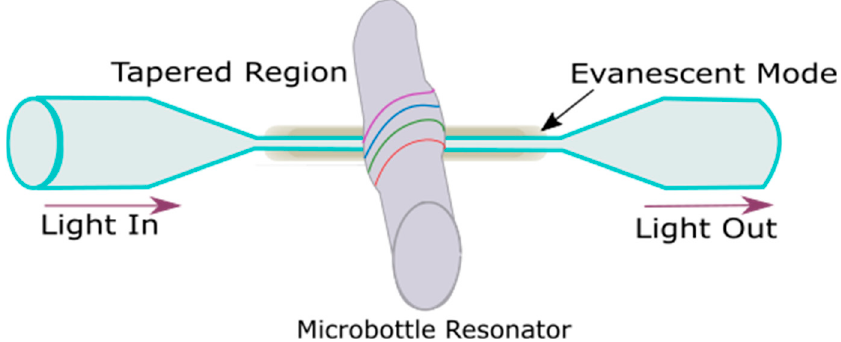
Figure 2. MBR coupling method; tapered fi ber coupling.